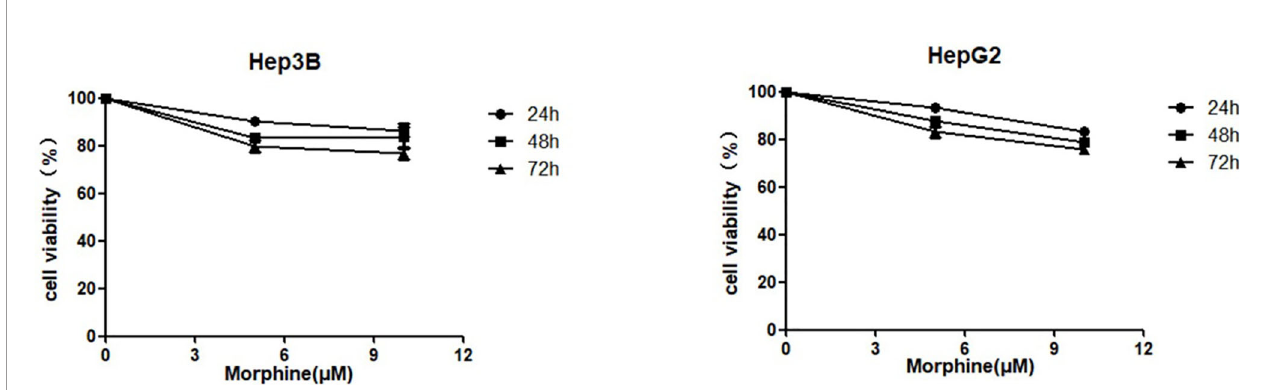
FIGURE 1 | Morphine does not promote proliferative ability to cultured liver cancer cells. Hep3B/HepG2 cells were pretreated with morphine at the concentration of 0, 5, 10 m M for 24h, 48h and 72h. Cell viabilities were measured by CCK-8 assay. Data are expressed as mean ± SE;